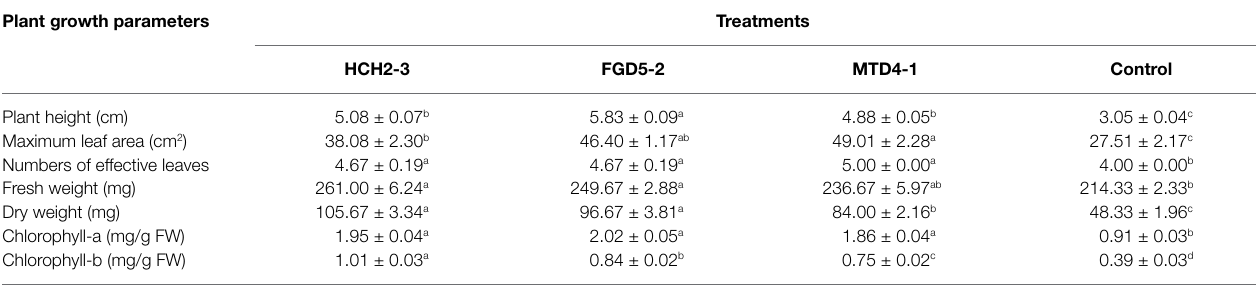
TABLE 2 | Comparison of tobacco growth and morphological traits (e.g., plant height and leaf area) between the control and inoculation